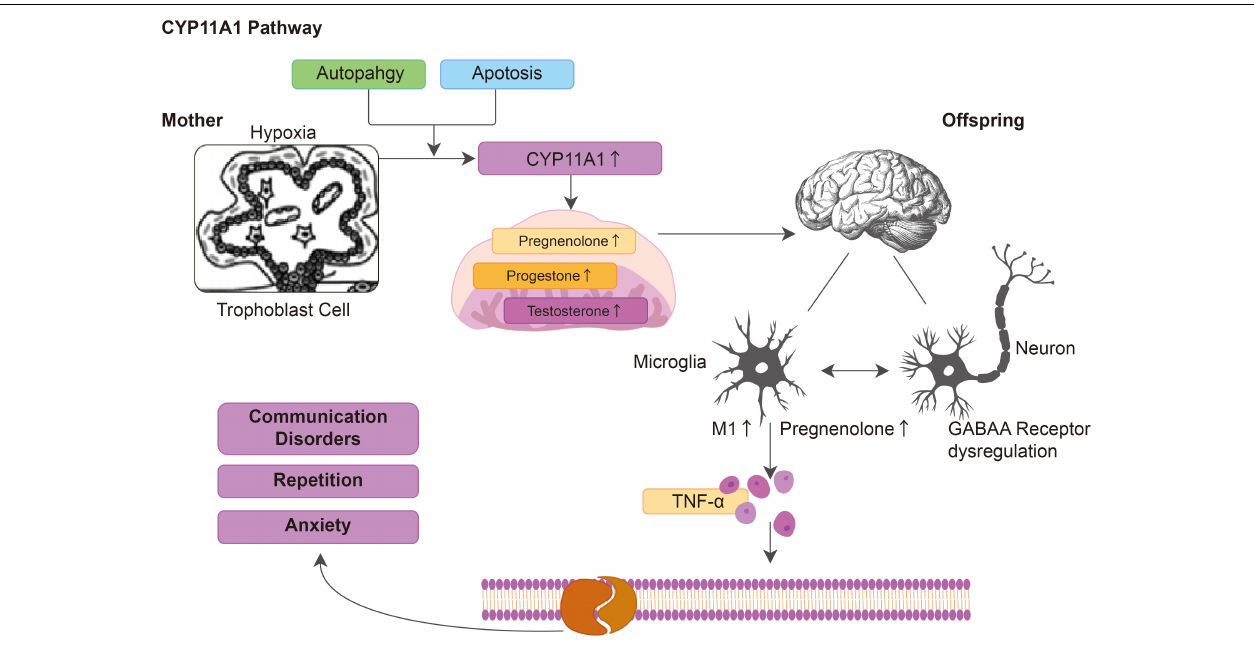
FIGURE 6 | The hypothesized model depicting dysregulated CYP11A1 expression leads to immune activation in microglia and dysregulated GABAA expression in neurons, which contribute to the autistic-like traits in CYP11A1-treated rat